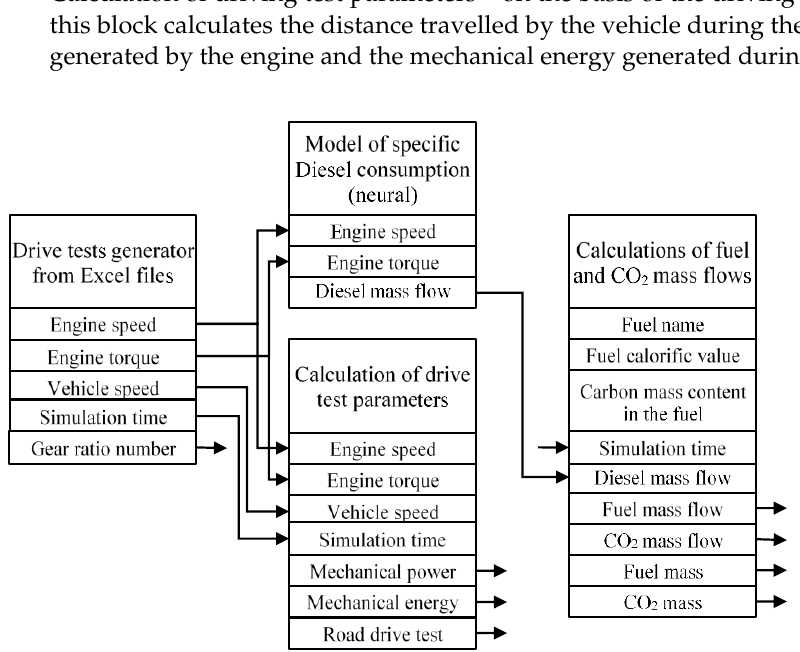
Figure 5. General schematic of the driving tests, including biofuels.